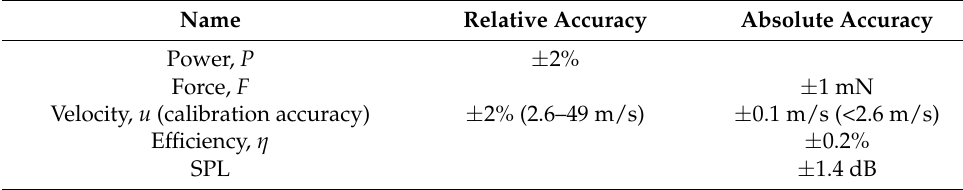
Figure 2. Scheme of the measurement stand with all the used equipment ( a ), photo of some parts of the measurement stand during velocity measurements ( b ), and a photo of the actuator during time mean reaction force measurements ( c ). Table 2. Measurement uncertainties.